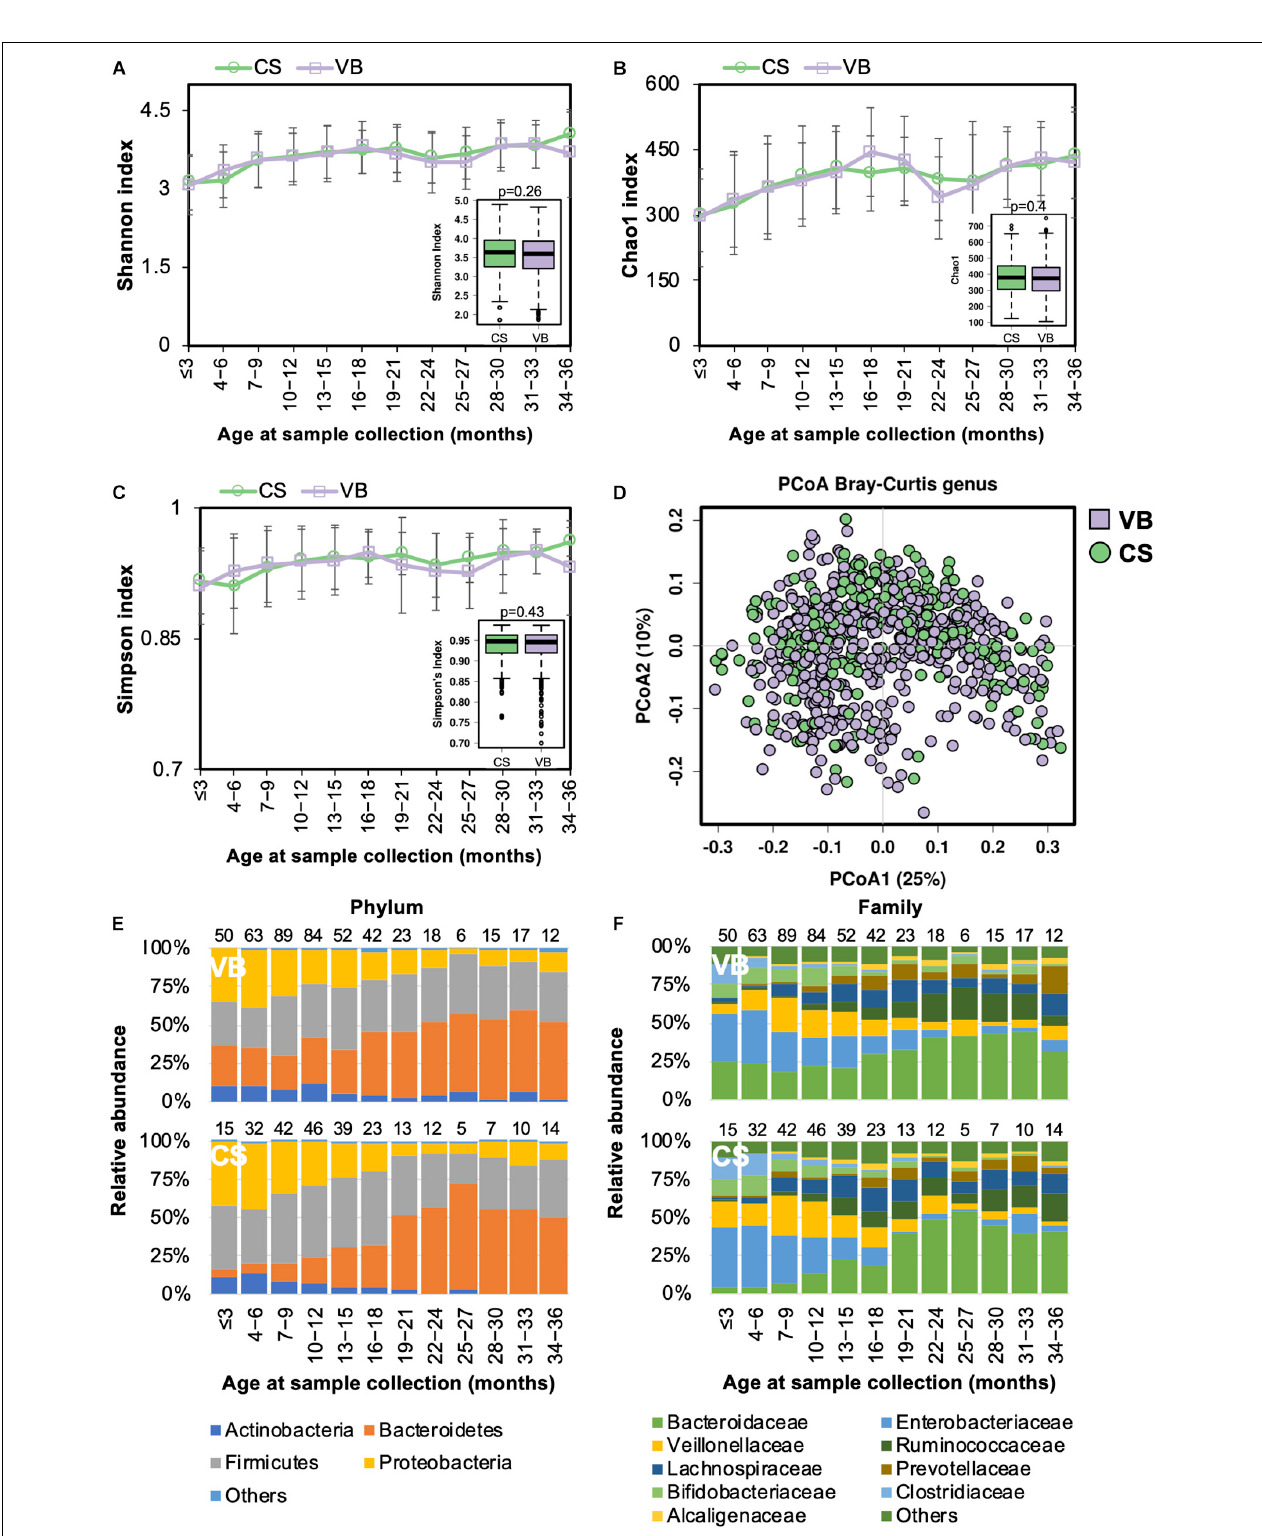
FIGURE 2 | Fecal microbiota diversity and composition for 729 children according to delivery mode. Alpha diversity, which was calculated by (A) Shannon index, (B) Chao1, or (C) Simpson’s index, showed no significant difference between the two birth modes. (D) PCoA showed no clear separation between samples based on the two birth modes. Birth-mode-stratified taxa summary composition of bacterial microbiota at the (E) phylum and (F) family levels. Number of children per age group is provided above bars.